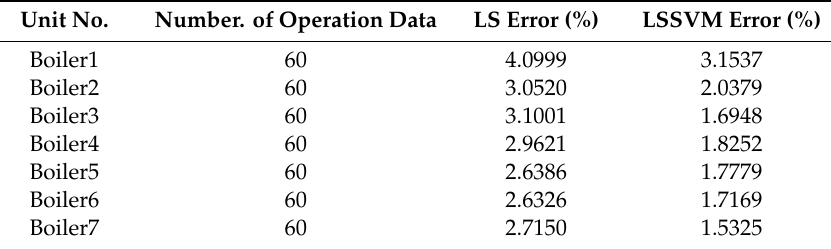
Table 4. The error results for the operation model of